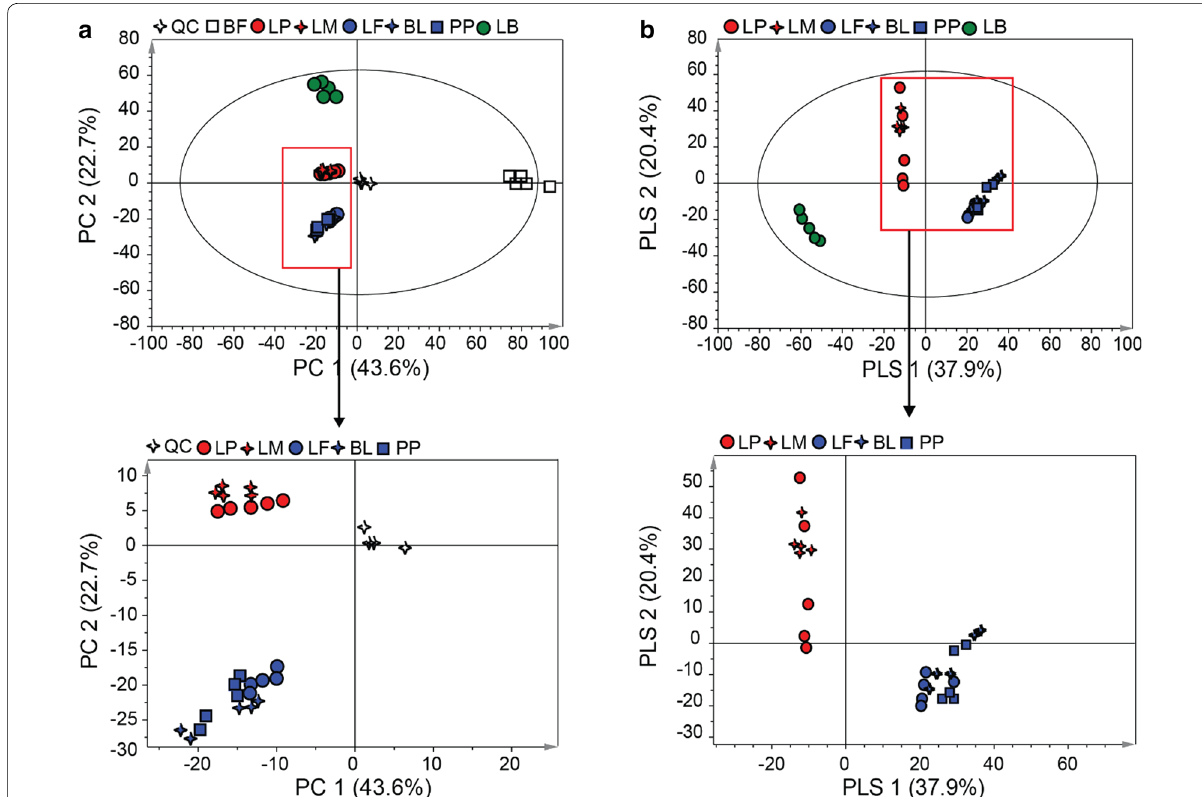
Fig. 2 PCA score plot ( a ) derived from GC–MS data of tomato samples fermented with different LAB strains, showing different metabolic profiles after 3 days of fermentation. QC (quality control) samples had good clustering in the center of PCA score plot, ensuring reliability of the metabolomics analysis. The score plot of panel ( b ) was generated after excluding samples before fermentation and QC samples in order to clarify metabolite similarity between LAB strains. Each symbol in the score plot represents a tomato sample fermented in a different batch. BF before fermentation, LP Lactobacillus plantarum , LM Leuconostoc mesenteroid , LF Lactobacillus fermentum , BL Bifidobacterium longum , PP Pediococcus pentosaceus , LB Lactobacillus